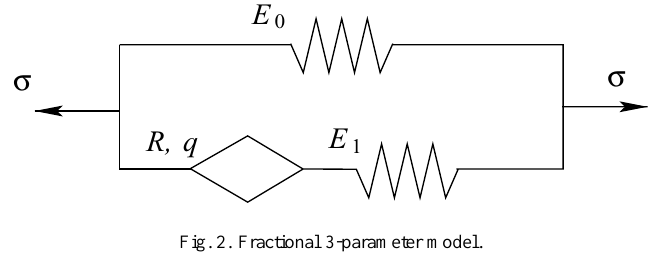
Fig. 2. Fractional 3-parameter model.